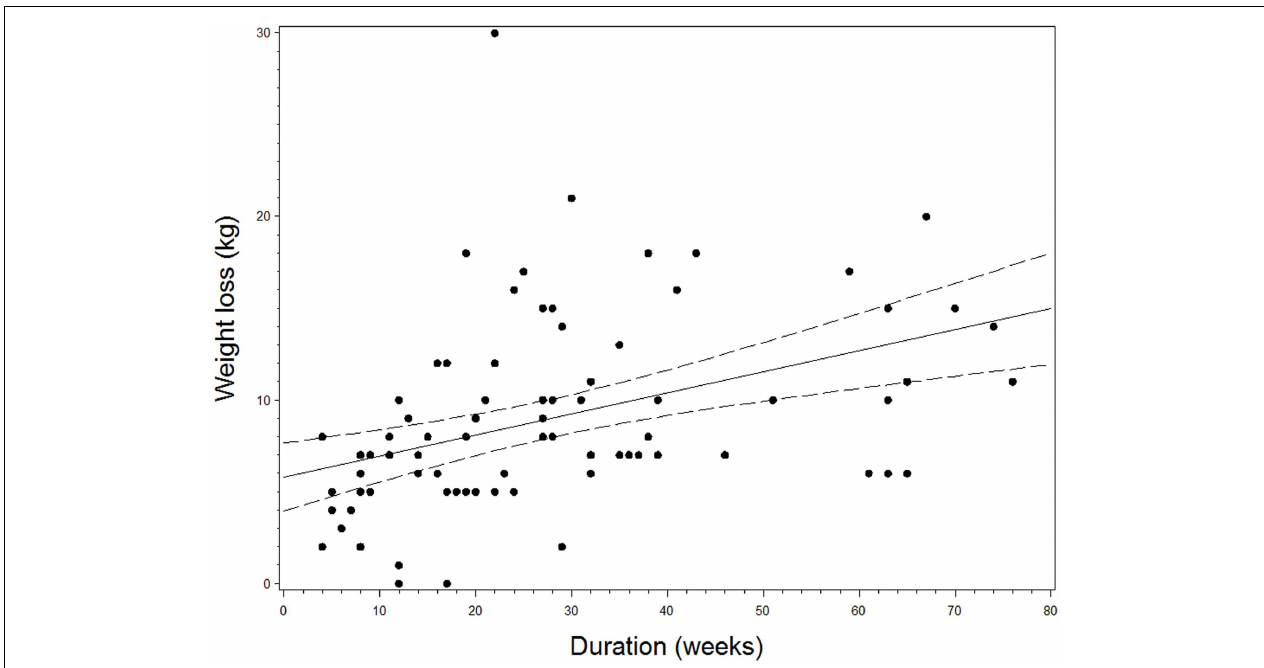
FIGURE 2 | Scatterplot of the relation between duration of treatment with liraglutide and weight loss with best fitted right line and 95% confidence interval .